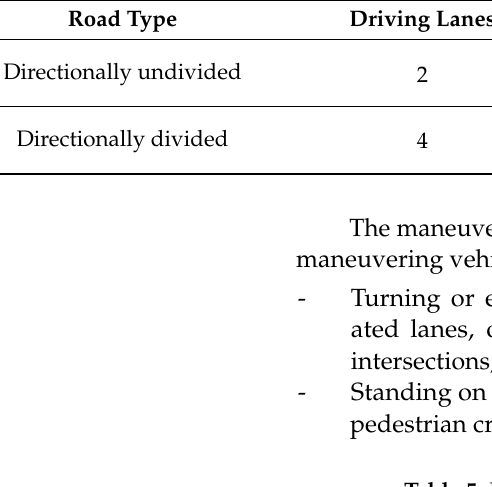
Table 5. Maneuvering factor values k m